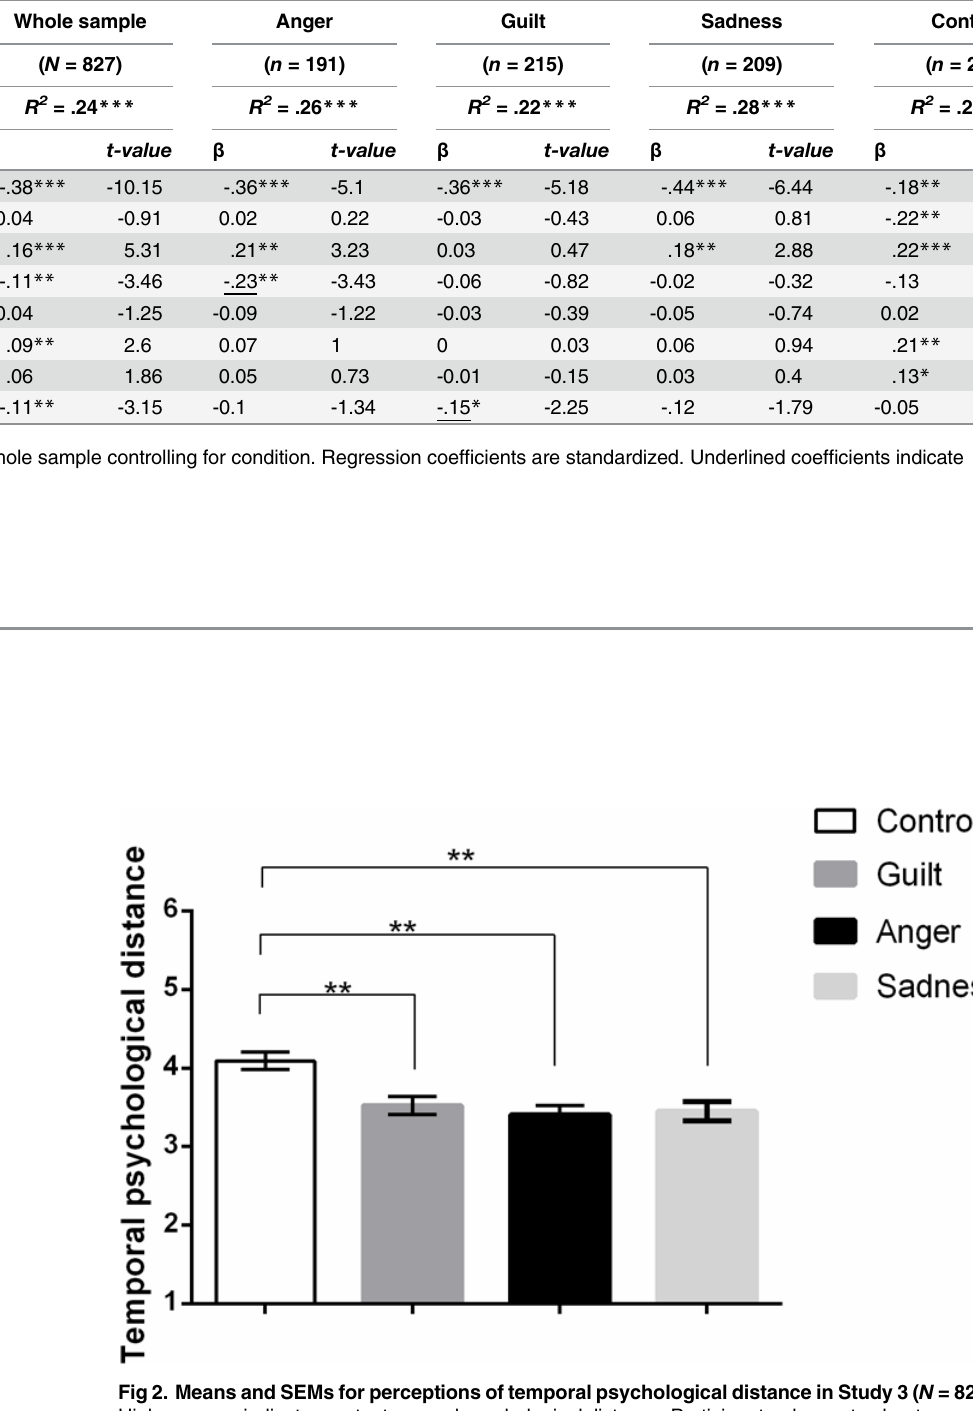
Table 5. Regression analyses from Study 3 predicting temporal psychological distance.